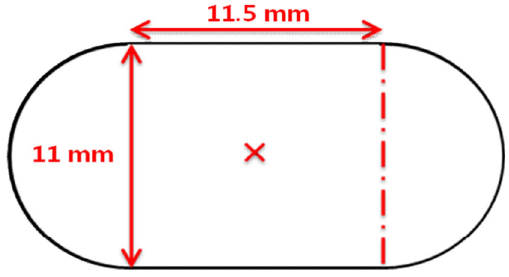
FIG. 12. Shape and size of the hole, which is added to the side of the full cell, used in